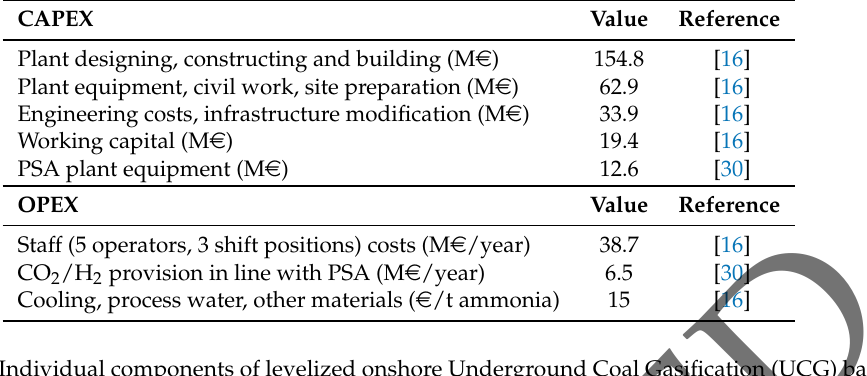
Table 12. Individual components of levelized onshore Underground Coal Gasification (UCG) based methanol production costs for 20 years of operation.